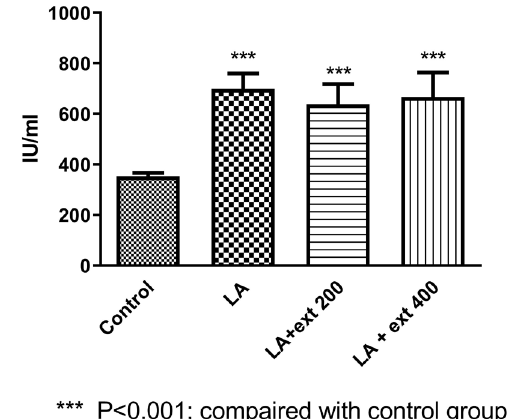
FIGURE 3 - Effect of Rheum ribes extract (ext) on the levels of alkaline phosphatase in rats treated with lead acetate (LA).